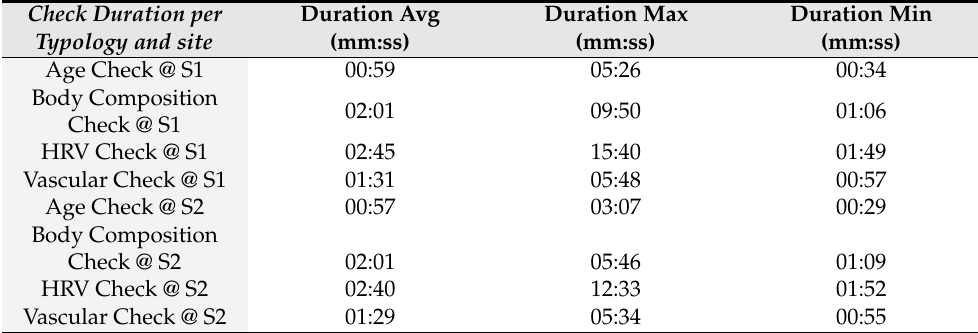
Table 2. Analysis of time for test completion in each domain for site S1 and